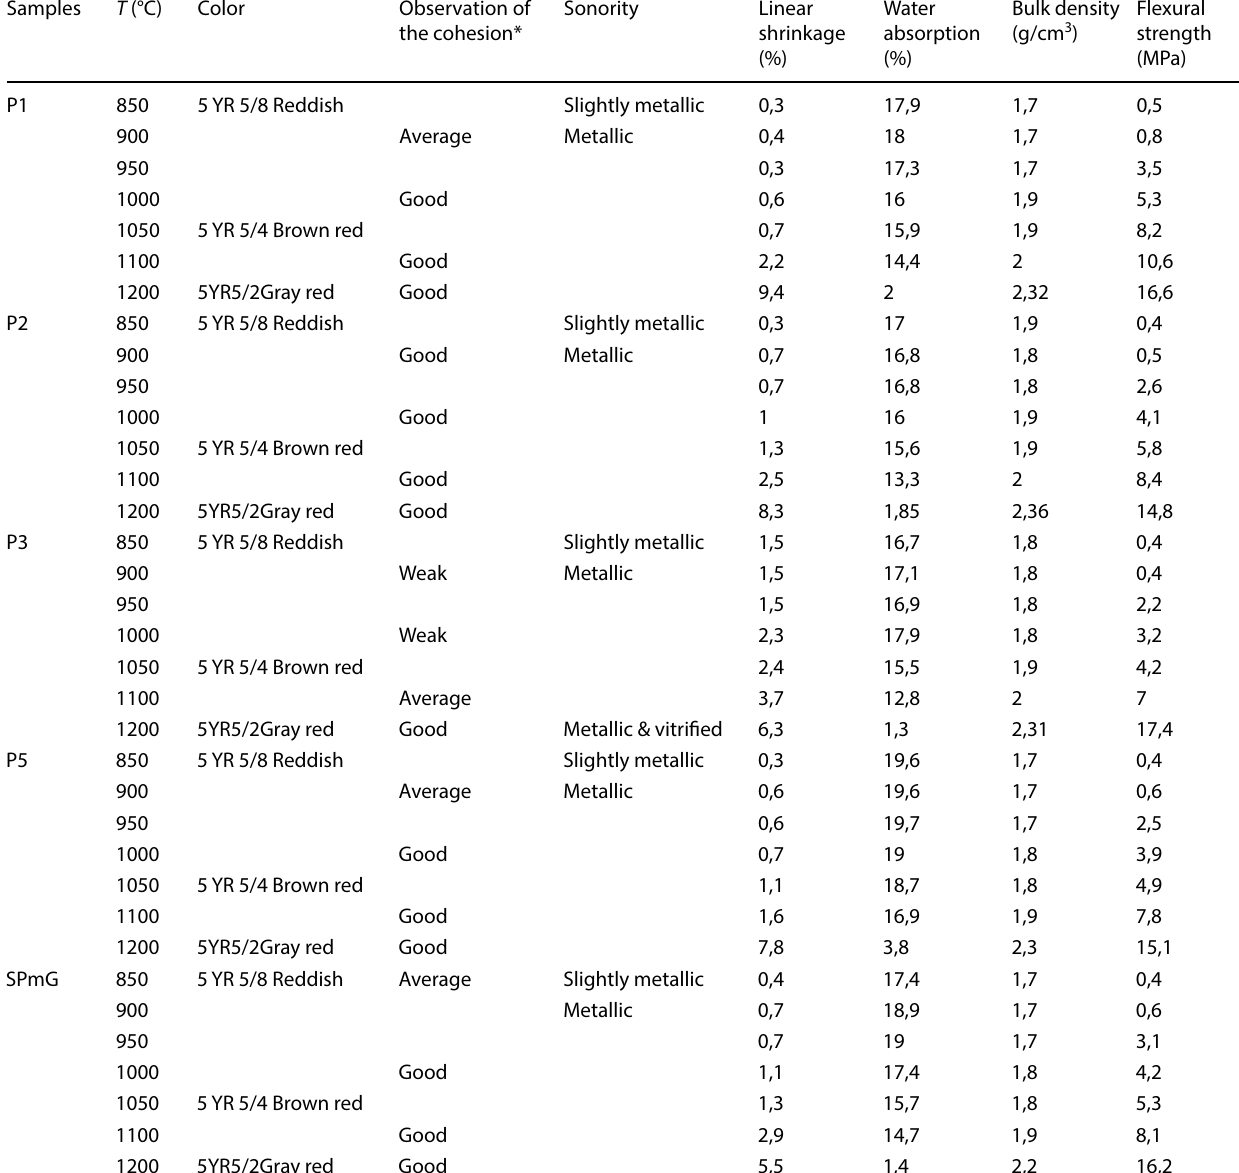
Table 5 Physical properties of fired specimens